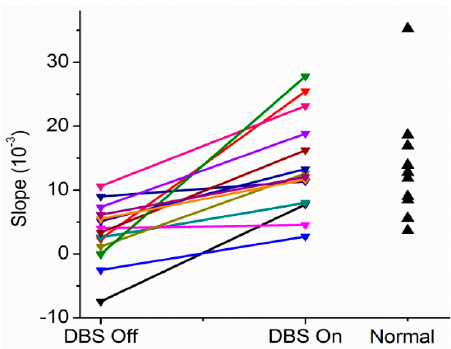
Figure 6. Summary of the changes in slopes of the motor unit recruitment order for 14 patients off and on therapeutic DBS compared to 10 normal controls.